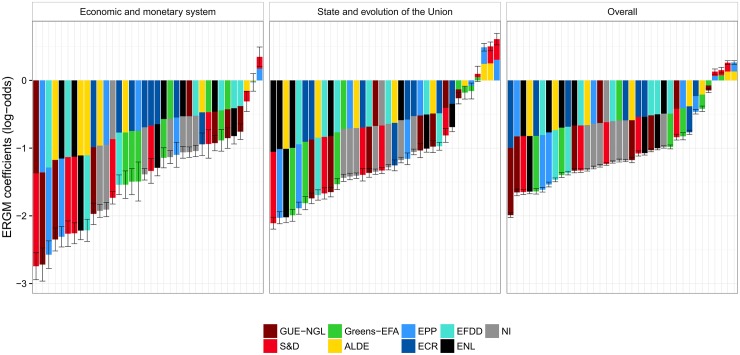
Coalitions between political groups in terms of RCVs as measured by ERGM.There are 36 possible pairwise coalitions of the nine groups. The coefficients of 0 indicate baseline, i.e., an even chance (0.5) of the two groups to co-vote together. For most group pairs, the probability to co-vote is lower than the chance: log-odds of −1 correspond to the probability of 0.27, log-odds of −2 to the probability of 0.12, and log-odds of −3 to the probability of 0.05. Note that ERGM does take abstentions into account, and therefore the baseline of co-voting by chance is considerably higher than for Alpha.